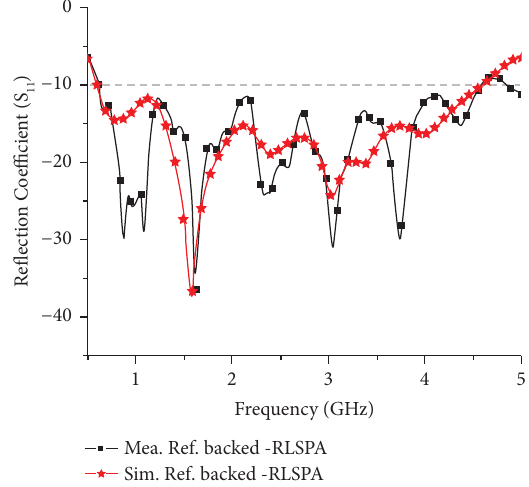
Figure 8: Simulated and measured S11 of reflector-backed